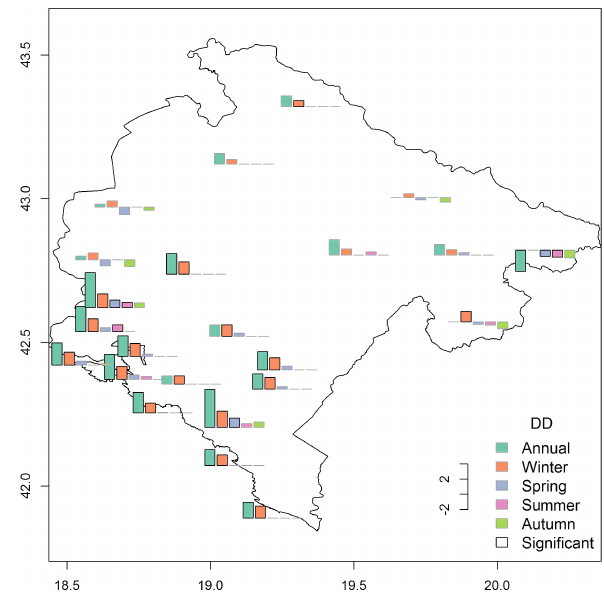
Figure 4. Decadal trends in the annual and seasonal number of dry days (DD) in daysdec − 1